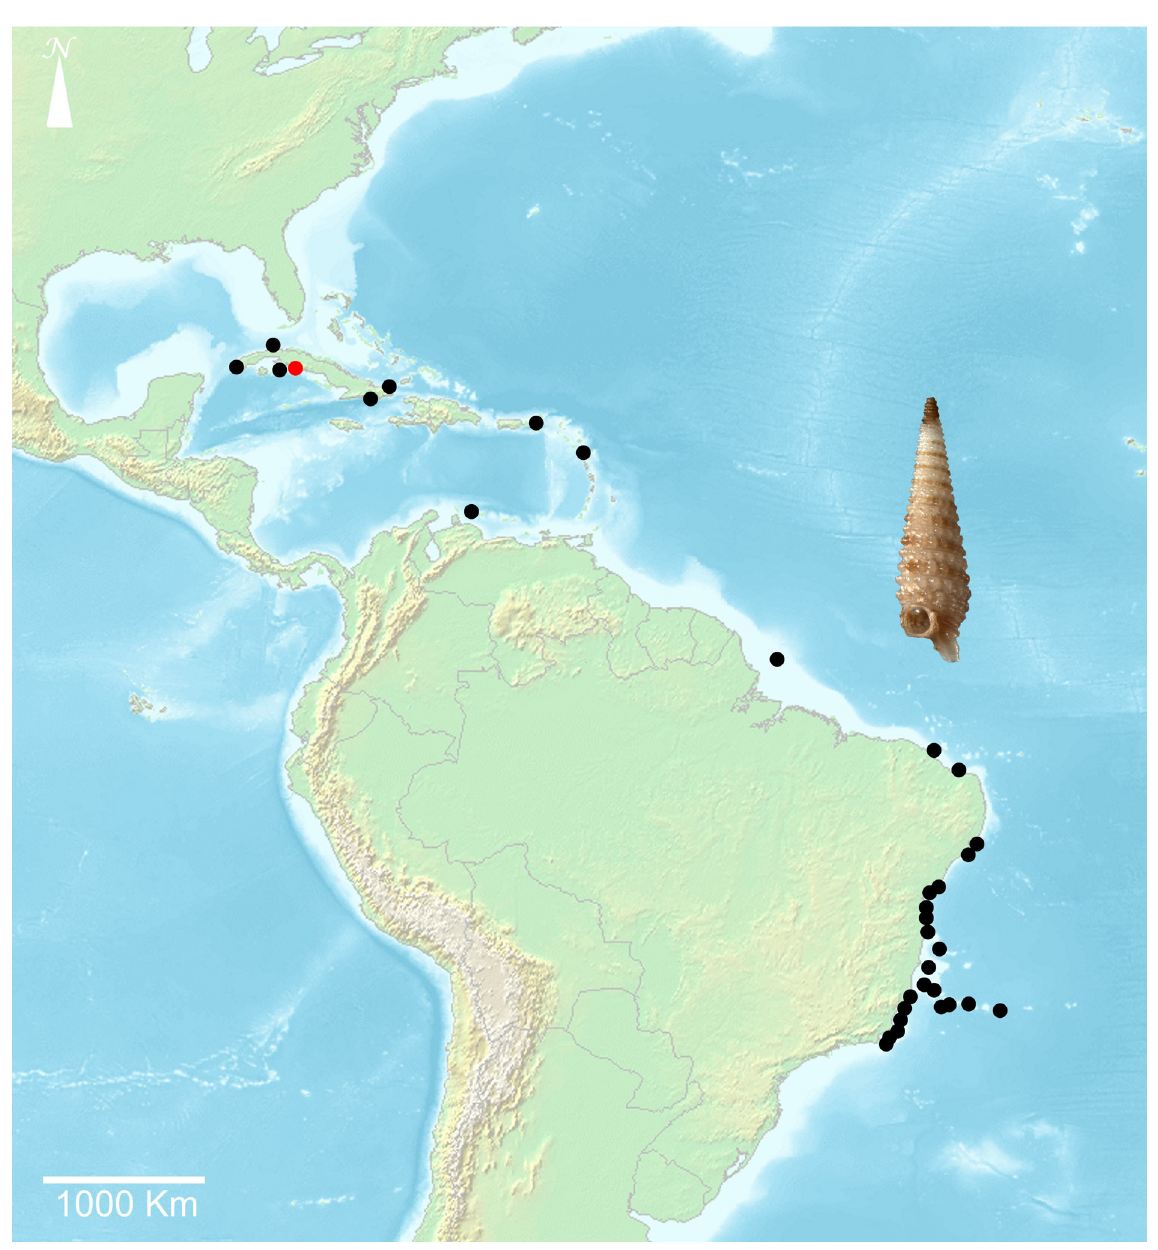
Fig. 49. Distribution map of Iniforis pseudothomae Rolán & Fernández-Garcés, 1993; red circle = type